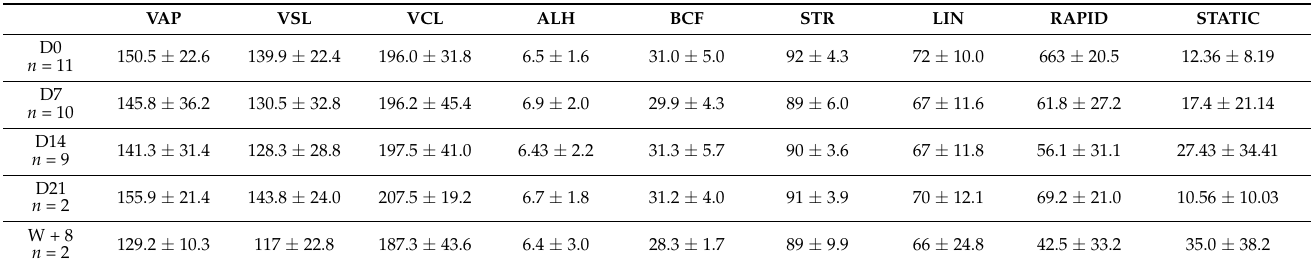
Table 4. Characteristics of sperm motility in semen fraction II samples collected from dogs in Group III (BPH treated with Deslorelin Acetate—SUPRELORIN ® VIRBAC ® ) compared to the study from day 0 ( n = 11). Results are presented as mean ± SD.